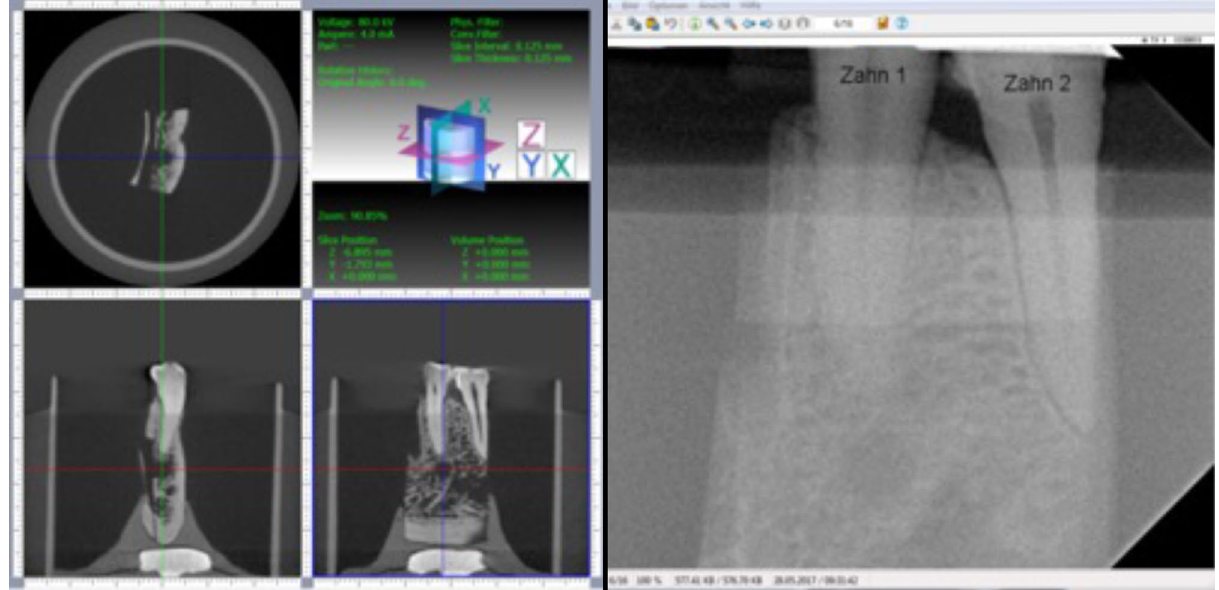
Figure 4. Screenshots of the working areas with CBCT (left) and DIR (right) with the same research specimen. The SAL observed correspond to a stage 5 (cortical bone perforated). On the DIR image it can be observed that the incision on the base and lingual aspects of the mandibles did not compromise the AA